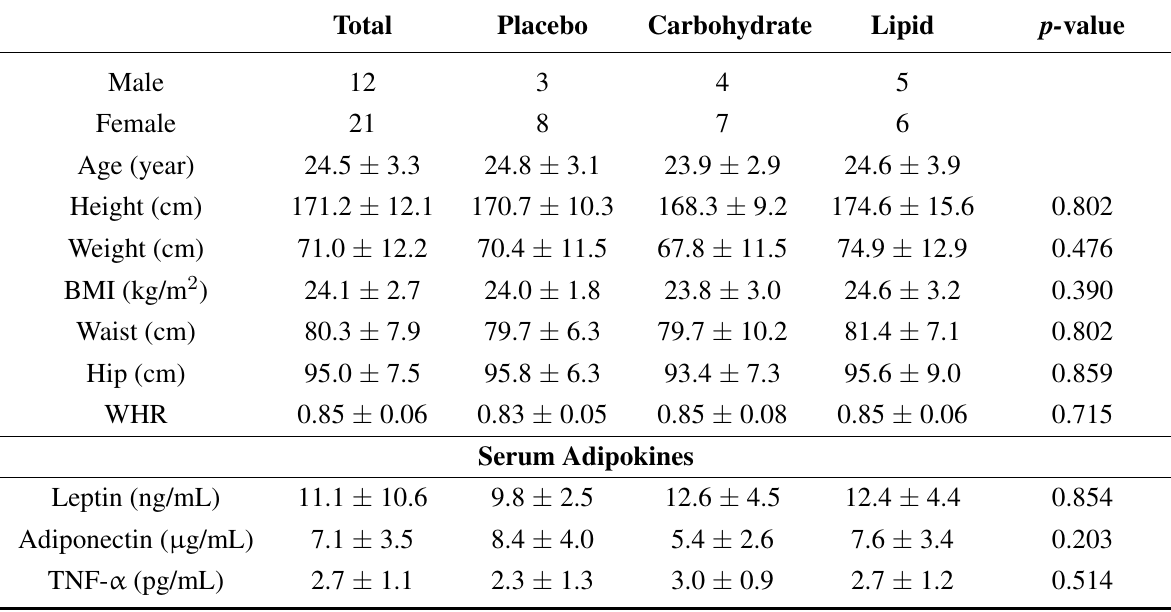
Table 1. Participants’ baseline characteristics.